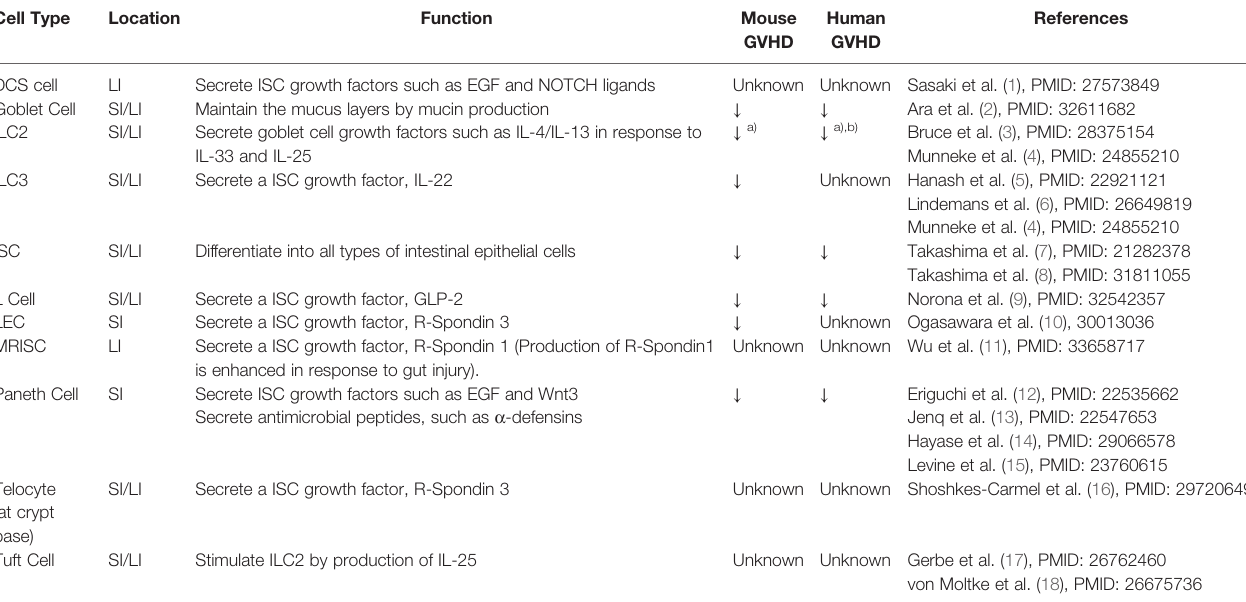
TABLE 1 | Intestinal cells that maintain intestinal